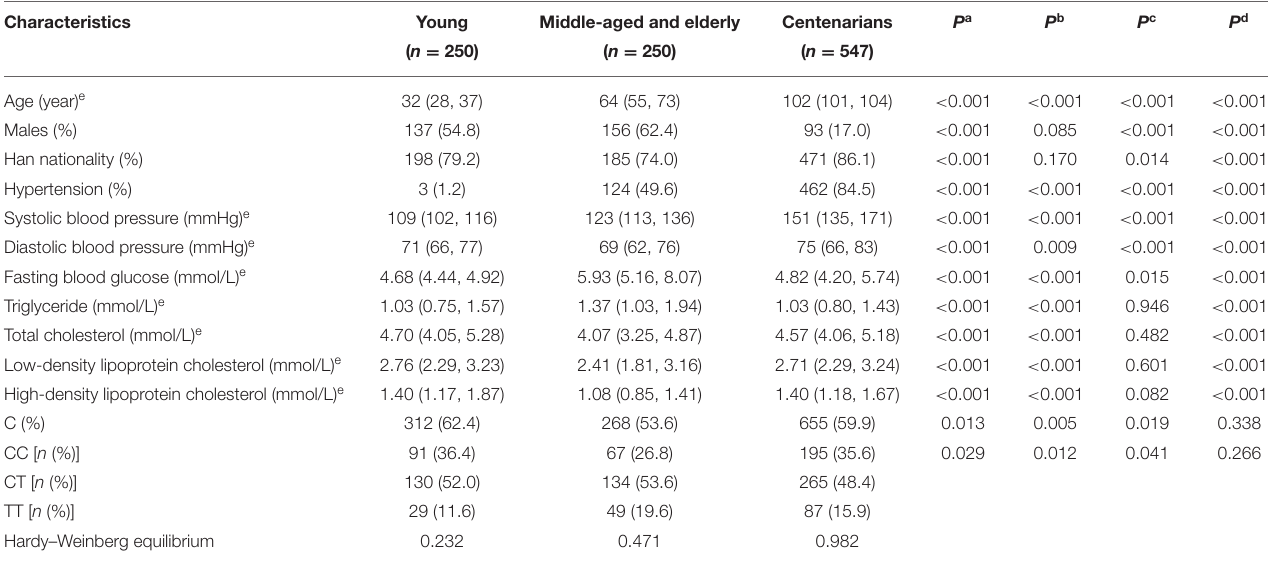
TABLE 1 | Basic characteristics of participants with different genotypes of